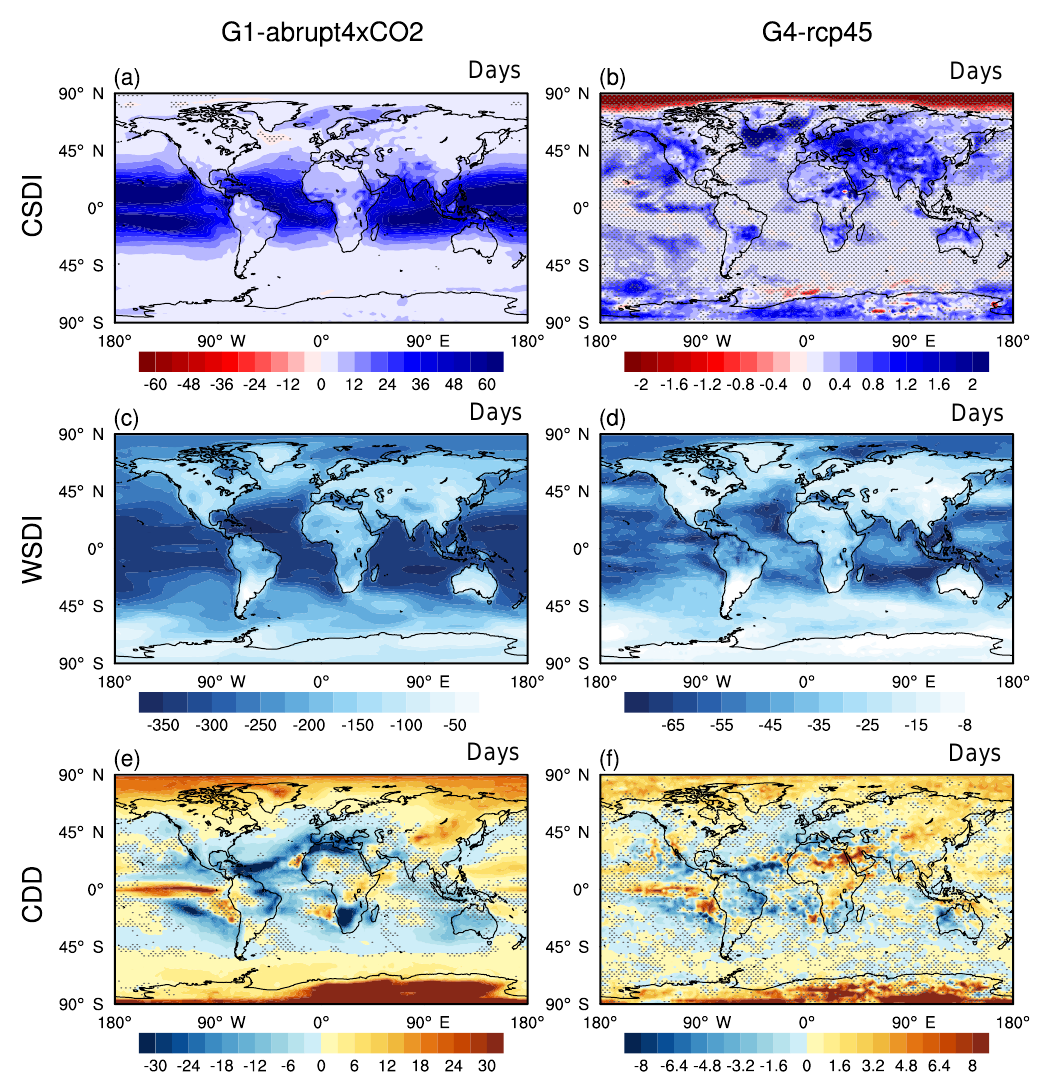
Figure 5. Geographical distributions of differences, G1 − abrupt4 × CO2 (a, c, e) and G4 − rcp45 (b, d, f) for the extreme duration indices (a, b) CSDI, (c, d) WSDI and (e, f) CDD, taken over the 40-year analysis periods. Stippling indicates regions where fewer than five of six models agree on the sign of the model